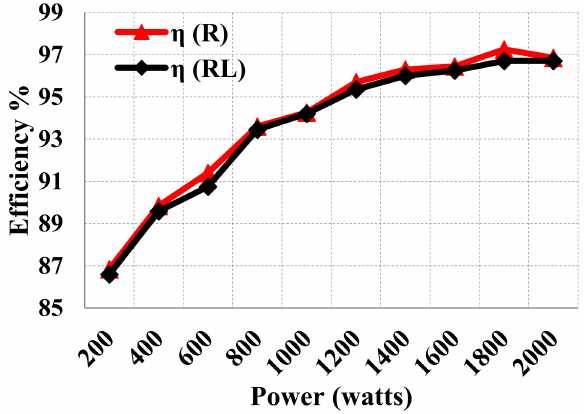
Figure 15. Experimental power conversion efficacy of